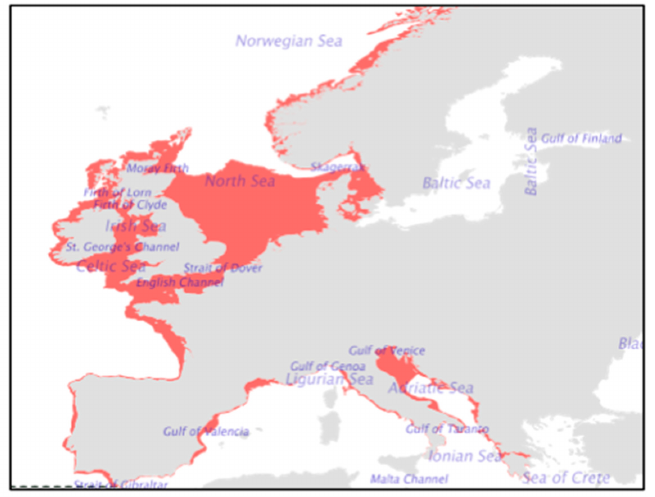
Figure 2. A diagram of the geographic distribution of brown crabs in Europe. Reproduced with permission from the European Market Observatory for Fisheries and Aquaculture Products [9]. 3. The Importance of the Brown Crab Fishing Industry and the Challenge of Cadmium: Ireland as an Example of a Crab-Trading Nation The seafood industry is significant to the Irish economy and contributes to a vibrant export trade with European and Asian countries, especially the PRC. The brown crab, or “portán dearg”, is the heaviest Irish crab and is landed by most major and some minor fishing ports in the country. The brown crab is a non-quota species and can be legally caught by vessels operating with a polyvalent or potting license [44]. Globally, the brown crab is a seafood species with increasing value, totalling a catch greater than 50,000 tonnes per year [45]. Exports of crustaceans and molluscs to the PRC from Ireland in 2018 in- creased by 68%, accounting for a total of 12,700 tonnes of seafood and growing the market to almost EUR 46 million [46]. Ireland has become one of the top three producers of brown crab products in Europe [47]. In 2018, landings of Irish brown crab reached 5500 tonnes, representing EUR 1 million in domestic sales and EUR 60 million in exports. Additionally, the price of Irish brown crab that year increased by 58% due to considerable demand from the Asian market, making brown crab the third most valuable export species that year. This increase in exports and price is of particular value to small-scale inshore fishermen in coastal communities around Ireland [48], although it should be noted that the Irish market was affected by the coronavirus disease 2019 (COVID-19) pandemic, with lower exports reported in 2020. The Irish brown crab exports reached a total of 2878 tonnes in 2020, representing a decrease of 47% compared with 2019, recording an exports value de- crease of 27% for the same period [9]. Chinese food import authorities have always been concerned regarding the levels of cadmium in all crustacean species originating from multiple countries, as they may exceed their limits of 0.5 mg/kg [9,49,50]. Ireland is not the only nation affected, as there are also reports of similar issues in Britain, Spain, France, Norway, Portugal, the Netherlands (mit- ten crab), the United States (Dungeness crab), and even Taiwan for various crab species exported to the PRC [8,9,49,51–53]. The main European countries exporting brown crab to the PRC have traditionally been the United Kingdom, Ireland, and France [6]. Initially,